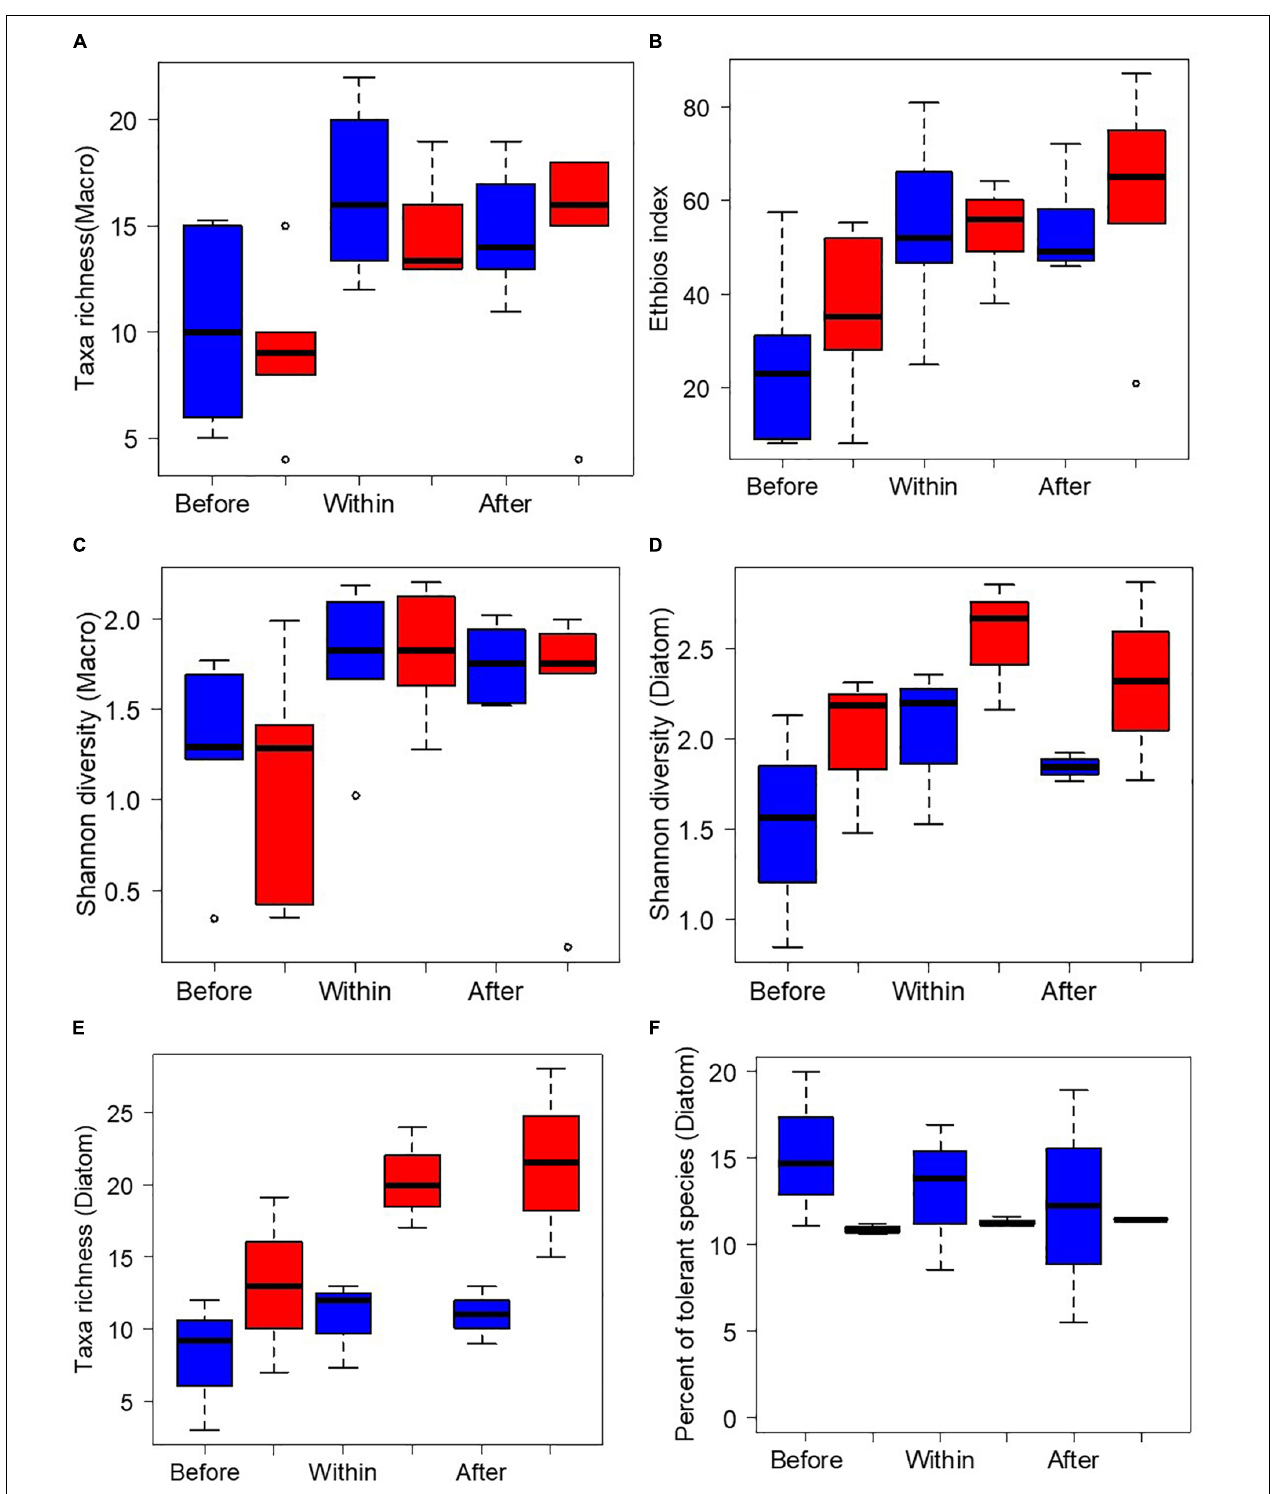
FIGURE 3 | Diversity and compositional metrics of macroinvertebrates: (A) taxa richness, (B) Ethiobios index, (C) Shannon diversity and diatoms: (D) Shannon diversity-diatom, (E) taxa richness-diatom, (F) percent of tolerant species in sites before joining the wetlands (“before”), within the wetlands (“within”), and after passing through the wetlands (“after”) in both dry (color: blue) and wet (color: red) seasons. The values are extracted from all the three wetlands i.e., “Boye,” “Fisho,” and “Kito” wetlands and the mean values are used.